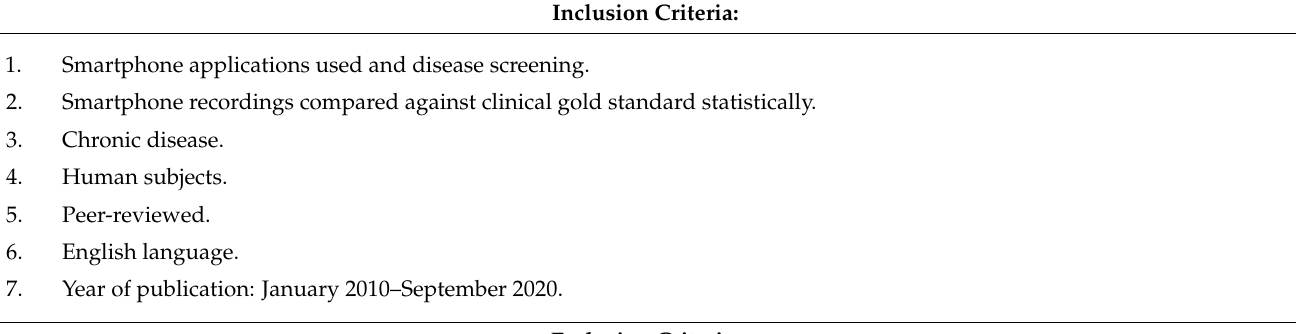
Table 1. Study selection criteria (adapted from